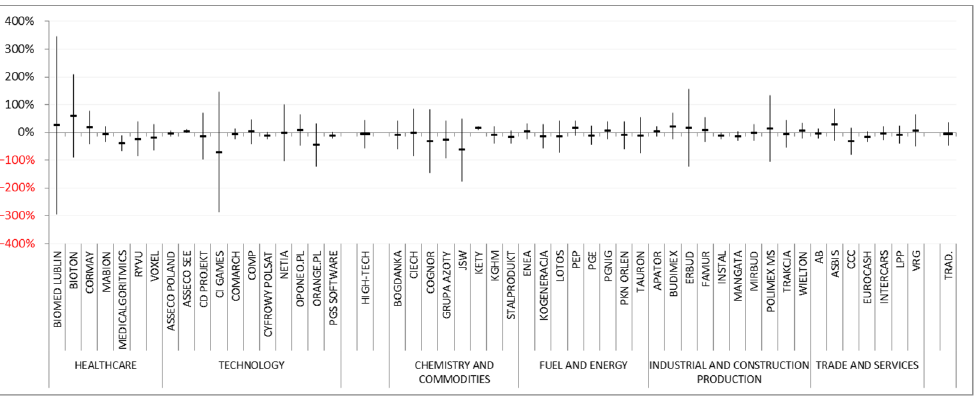
Figure 17. A typical area of variation of the rate of return on assets in the surveyed enterprises. Source: own work.